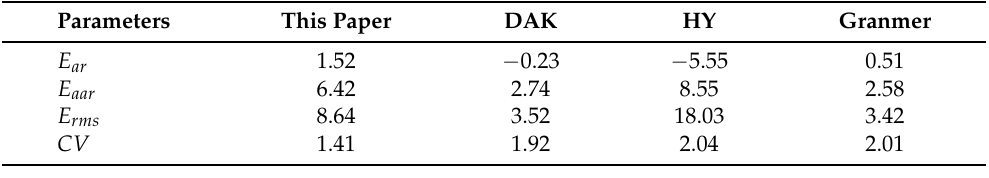
Table 3. The statistical results of the four methods when predicting compressibility factors of the six natural gas samples with different contents of CO 2 .